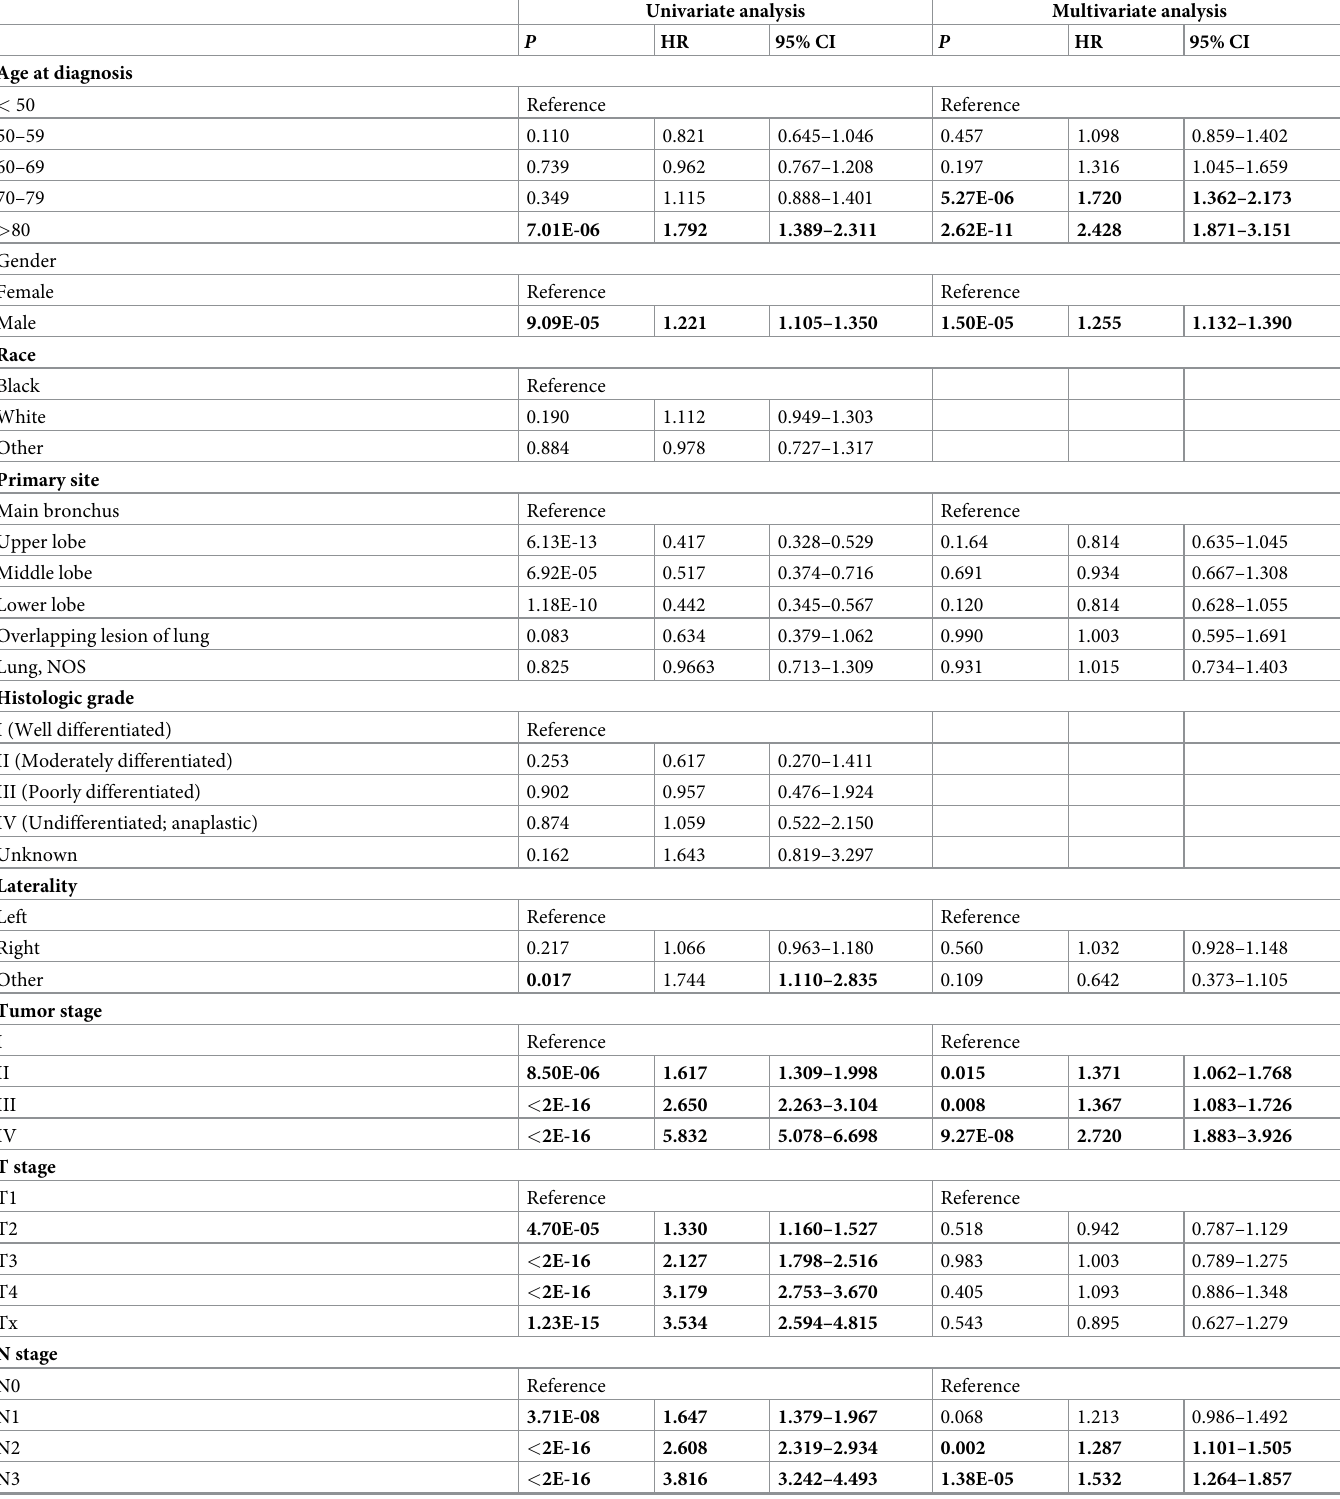
Table 2. Univariate and multivariate analyses of variables for overall survival (OS) in the training